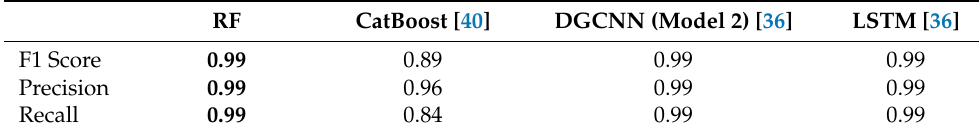
Table 6. Comparative analysis with cutting-edge works (Imbalanced Data